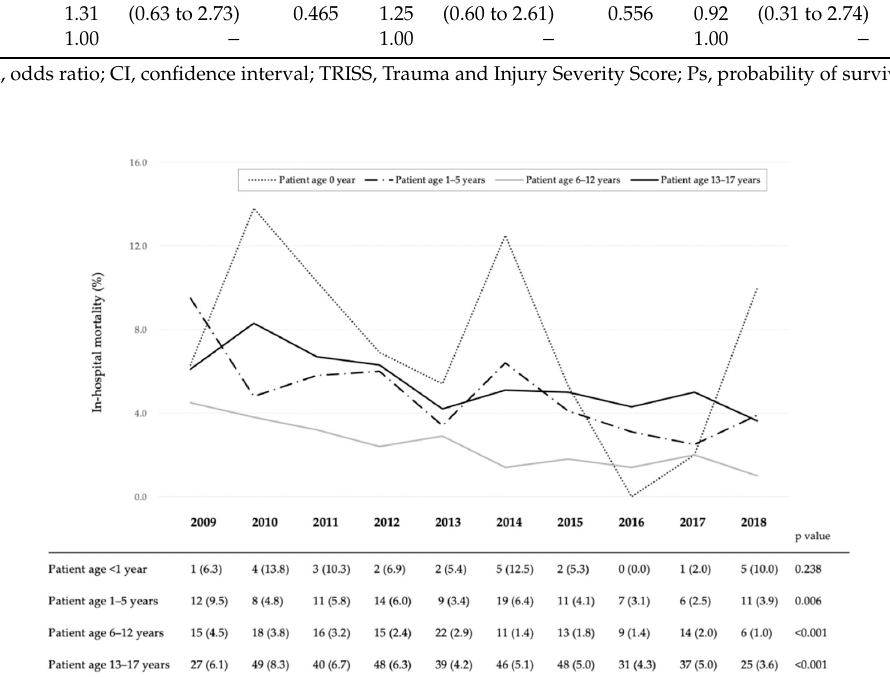
Figure 3. Yearly in-hospital mortality trends according to age group of paediatric injured patients.